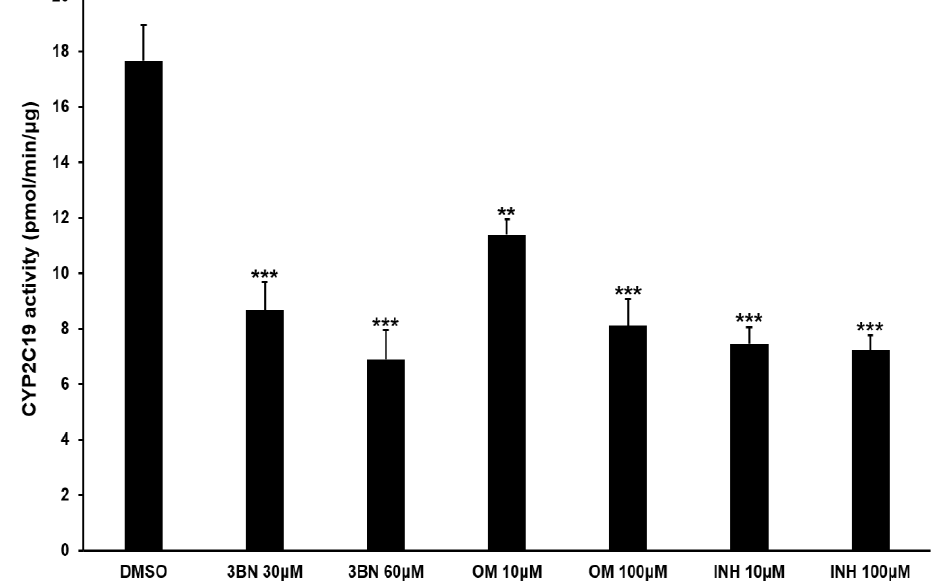
Figure 4. CYP2C19 enzyme activity assay in M2 macrophages. Membrane fractions of M2 macrophages were incubated with the prototype substrate. The activity was measured using excita- tion and emission wavelengths of 406 and 468 nm, respectively, and was compared with a standard curve. Additional details can be found in the Materials and Methods. Inhibitors of CYP2C19 were used in the reaction to confirm that the reactions were specific to CYP2C19 activity. Data are presented as the mean ± standard deviation of three independent assays. 3BN, (+)-N-3-benzyl-nirvanol; OM, omeprazole; INH, isoniazid. ** p < 0.01 and *** p < 0.001 versus the vehicle